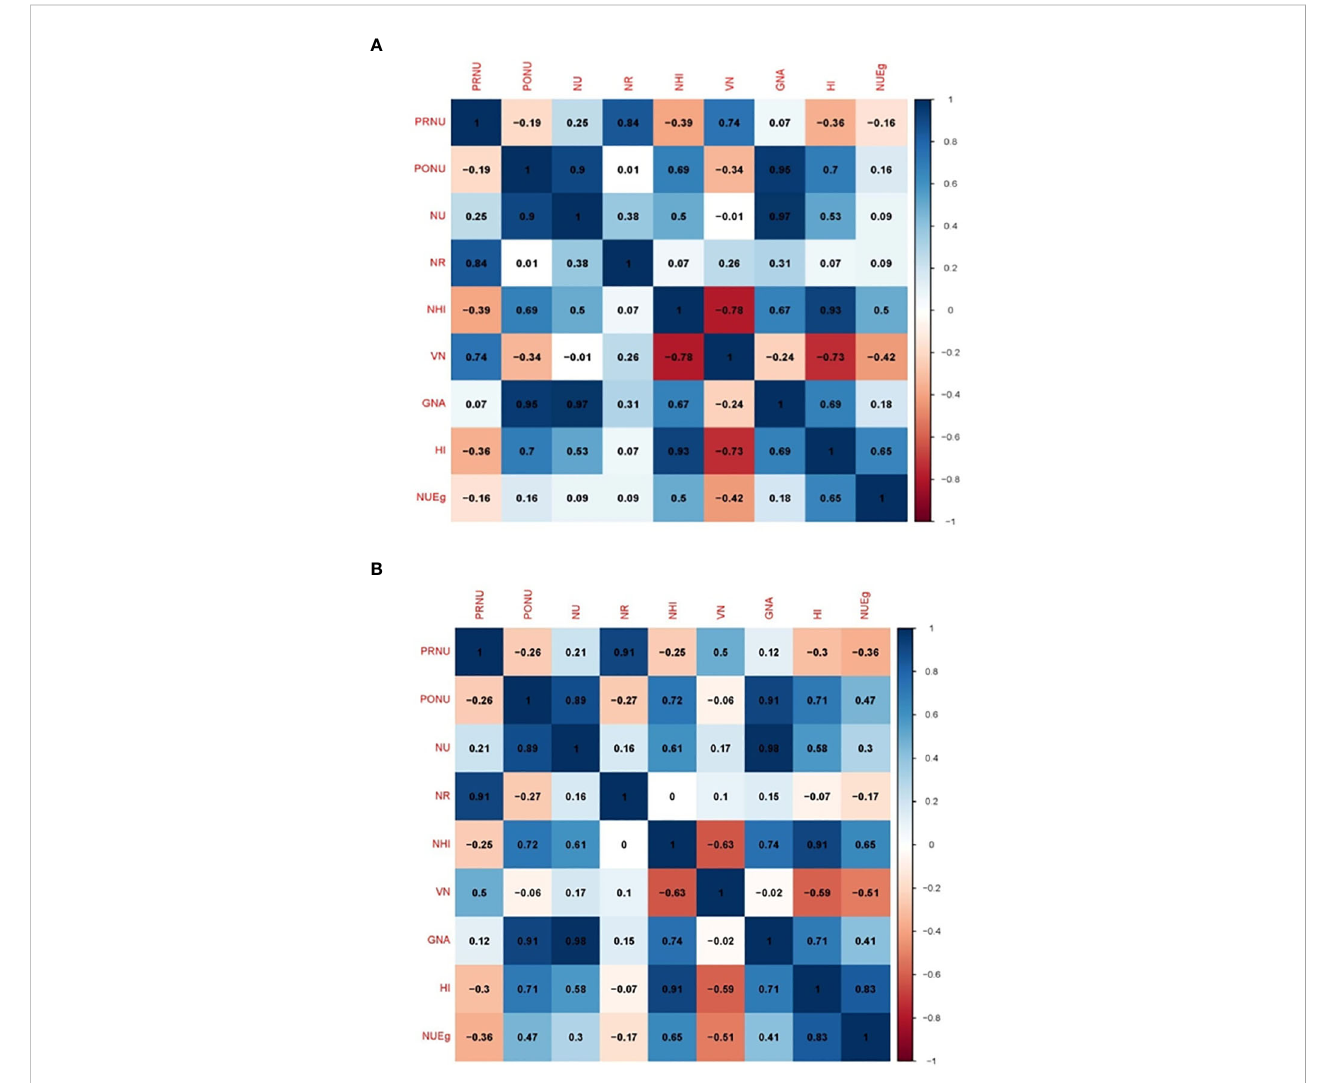
FIGURE 11 Pearson correlation matrix showing the relationship between PRNU (pre-anthesis nitrogen uptake), PONU (post-anthesis nitrogen uptake), NU (total nitrogen uptake), NR (nitrogen remobilization), NHI (nitrogen harvest index), VN (total vegetative nitrogen), GNA (total grain nitrogen accumulation), HI (harvest index), and NUEg (nitrogen grain production ef fi ciency) under (A) nitrogen de fi cient (0 kg ha-1 fertilizer N: N0), (B) nitrogen suf fi cient (120 kg ha-1 fertilizer N: N120) fi eld